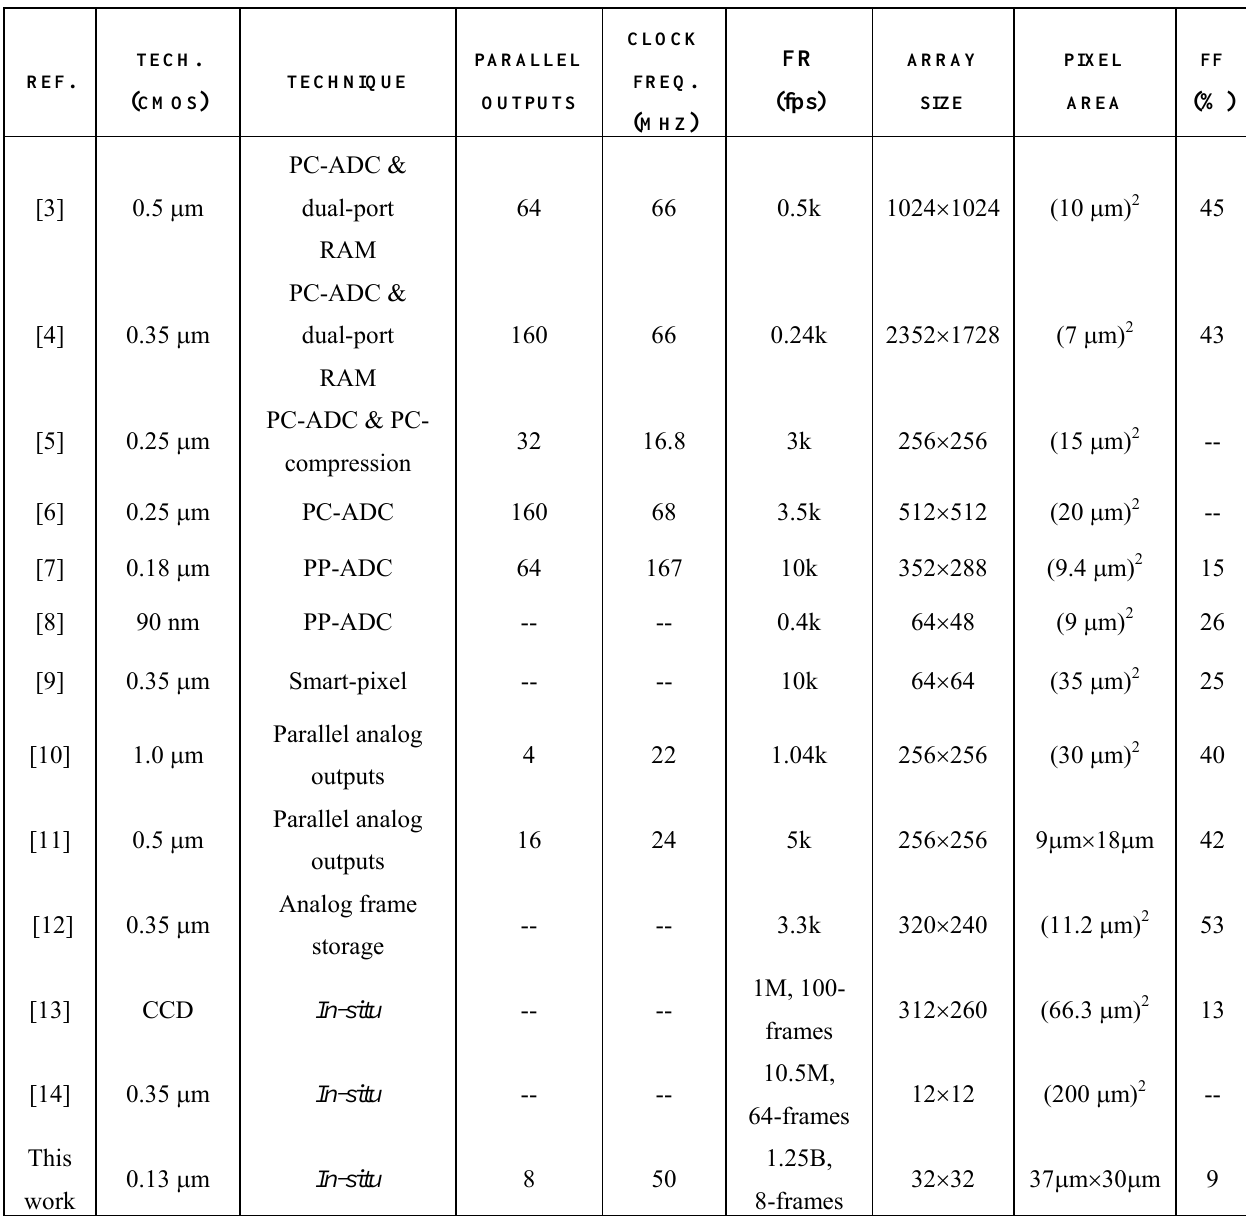
Table 1. Summary of the various high-speed imagers available in the literature.